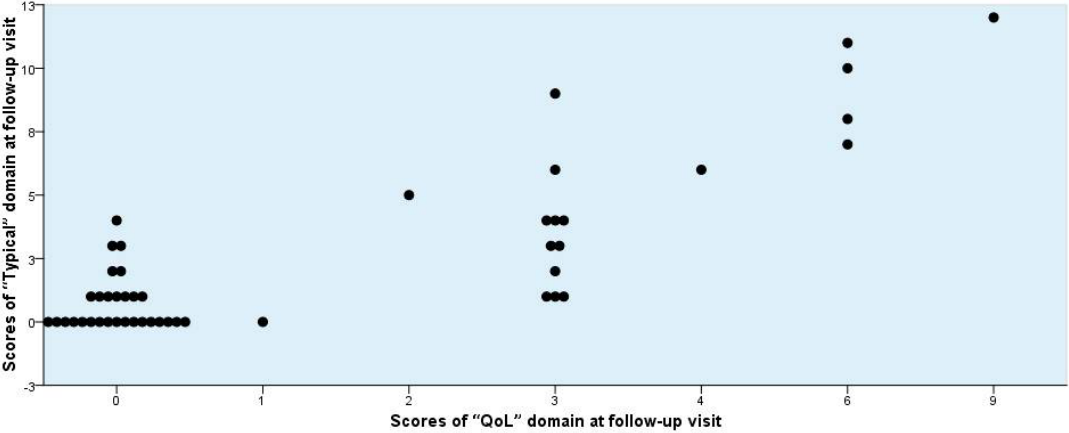
Figure 5. Individual scores for “Typical” versus “Quality of Life (QoL)” domain obtained from 48 female patients at the follow-up visit.